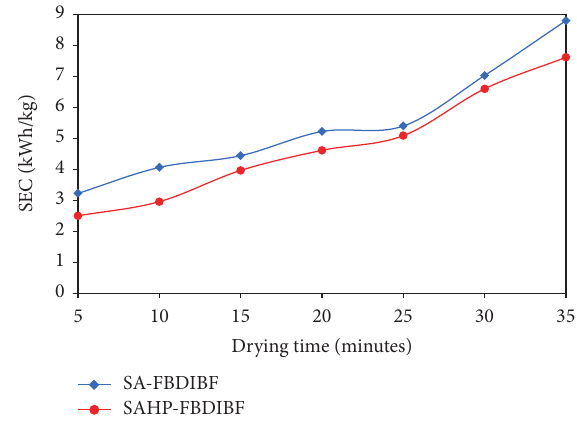
Figure 18: The variation of SEC with drying time.